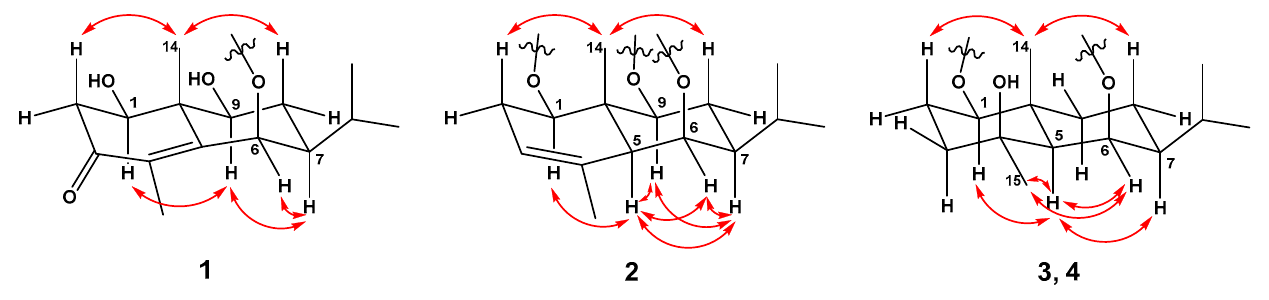
Figure 3. Key NOESY( ↔ ) correlations of compounds 1 − 4 .